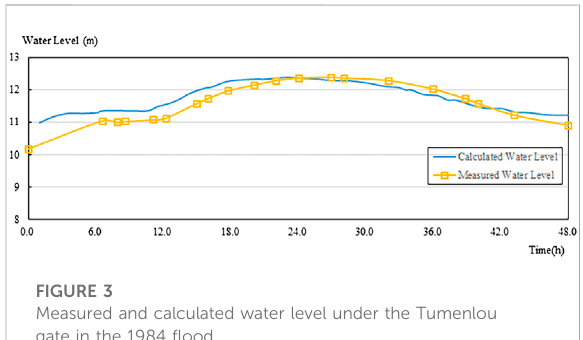
FIGURE 3 Measured and calculated water level under the Tumenlou gate in the 1984 fl